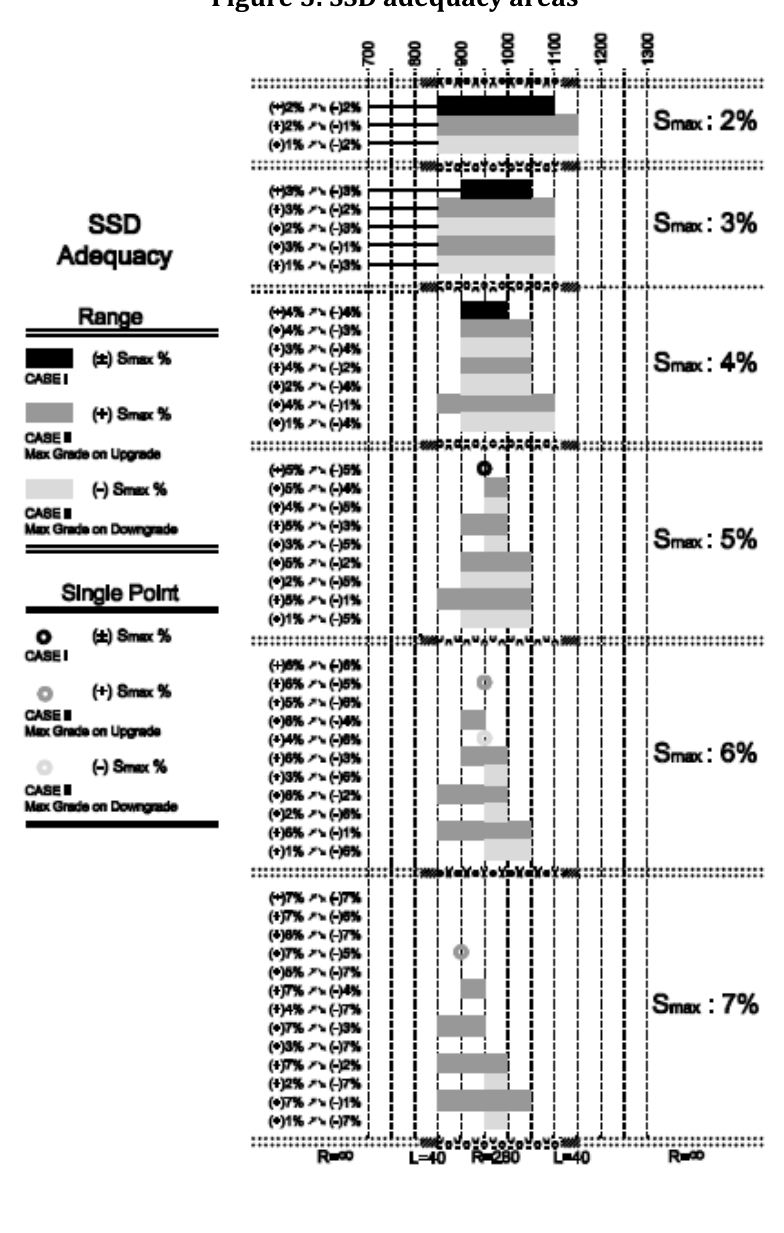
Figure 5: SSD adequacy